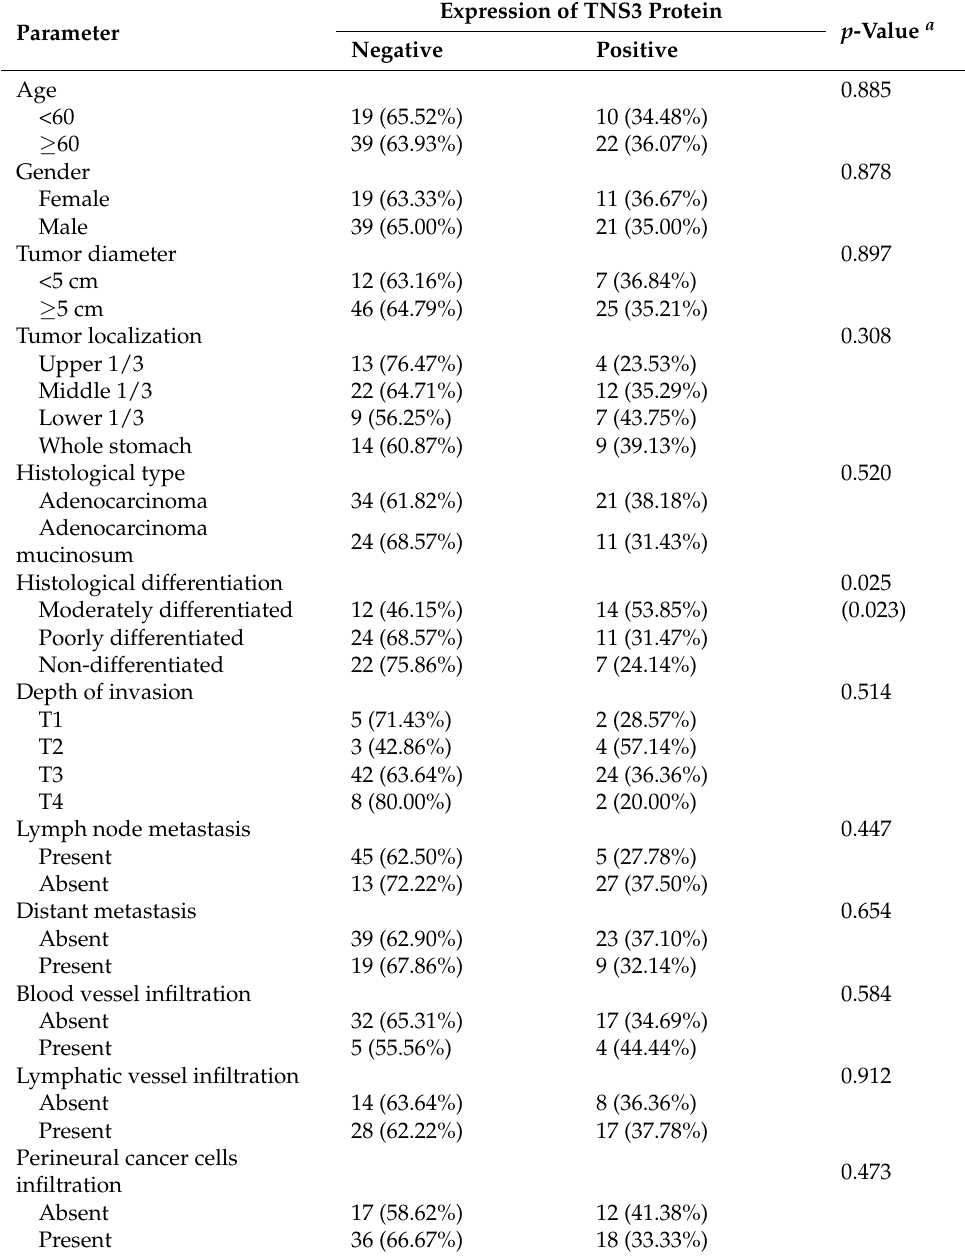
Table 4. Correlation between TNS3 protein expression level in gastric cancer and clinicopathologi- cal